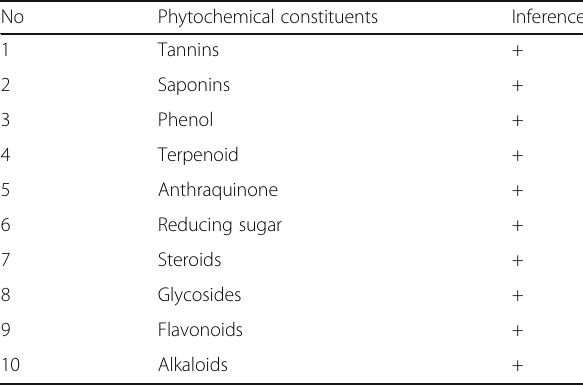
Table 2 Phytochemical Screening of aqueous extract of fruit pulp of A. digitata